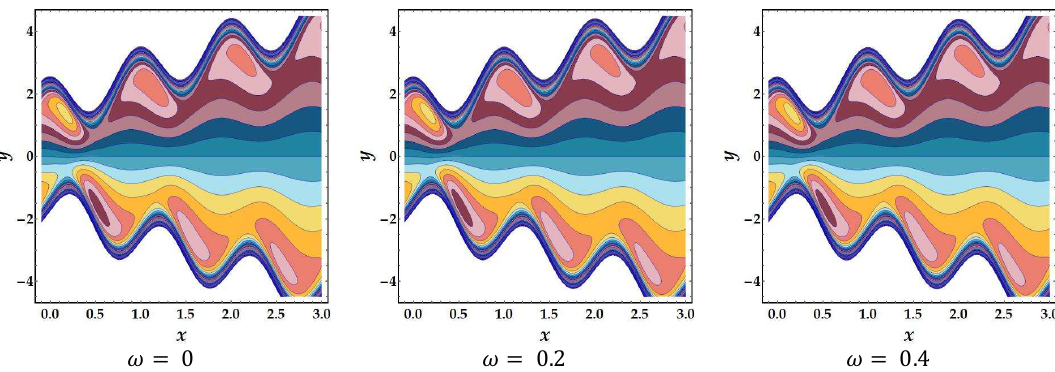
Figure 13. The behavior of Streamlines for different values of eccentricity parameter ω